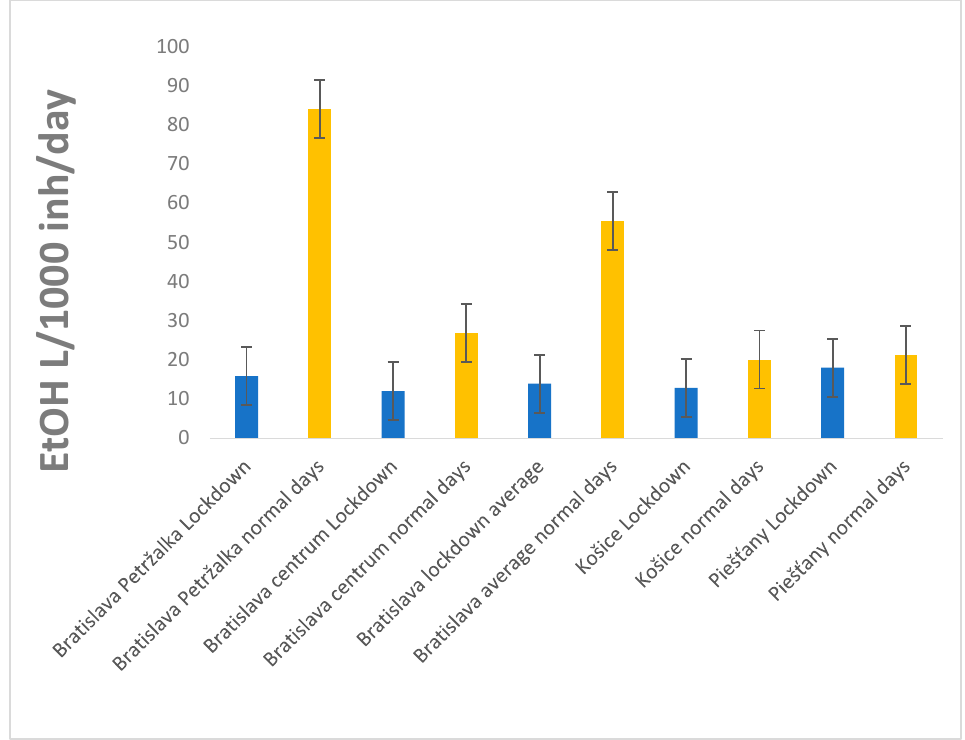
Figure 1. Average alcohol consumption (L/1000 inh/day) in three Slovak cities during the lockdown and a period with lighter restrictions in 2020 (marked as “normal” and orange color). Error bars represent the standard deviation of the values for each period.